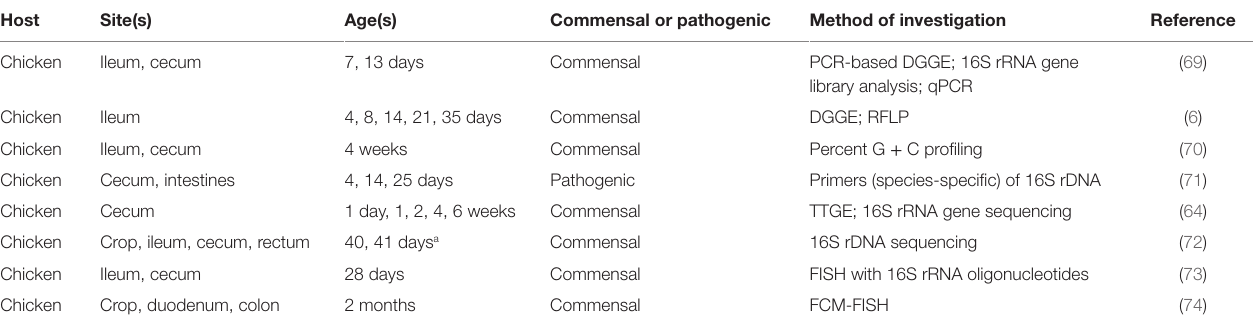
TABLe 2 | Research conducted on commensal bacteria in poultry GiT based on